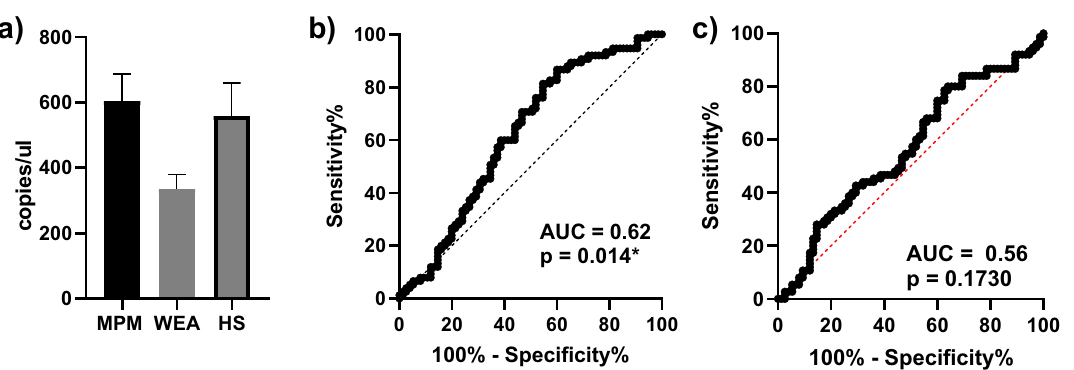
Figure 2. MiR-197-3p analysis by RT-qPCR. ( A ) WEA and HS cohorts: the amount of miR-197-3p is represented as copies/µl of analyzed cDNA (ANOVA P = ns; Tukey’s test: MPM vs WEA P = ns; MPM vs HS P = ns; WEA vs HS P = ns). ( B ) ROC curve for the comparative analysis of miR-197-3p levels in MPM vs. WEA; ( C ) ROC curve for the comparative analysis of miR-197-3p levels in MPM vs.